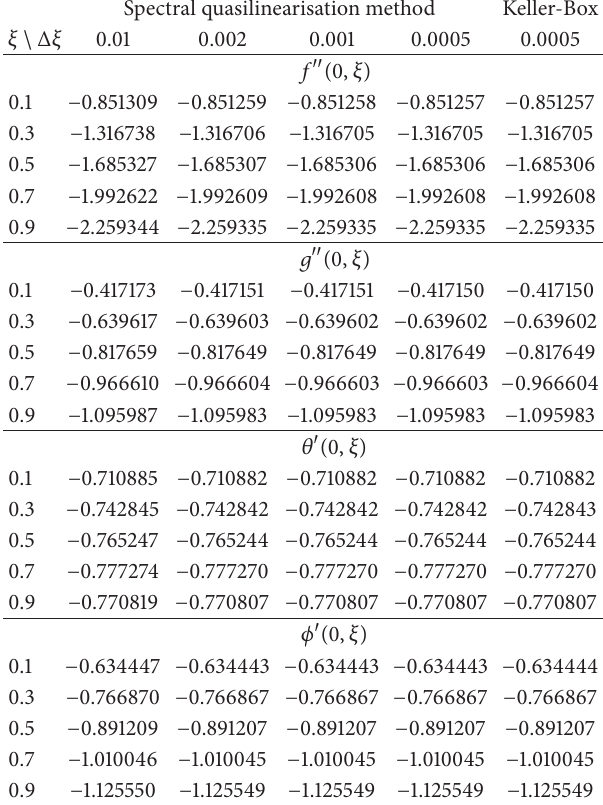
Table 5: Comparison between the SRM and Keller-Box approxi- mate numerical values for 𝑓 󸀠󸀠 (0, 𝜉 ), 𝑔 󸀠󸀠 (0, 𝜉 ), 𝜃 󸀠 (0, 𝜉 ), and 𝜙 󸀠 (0, 𝜉 ) when 𝜆 = 0.5 , 𝑀 = 2 , 𝑐 = 0.5 , Sc = 𝛾 = 1 , and Pr = 1.5 in Example